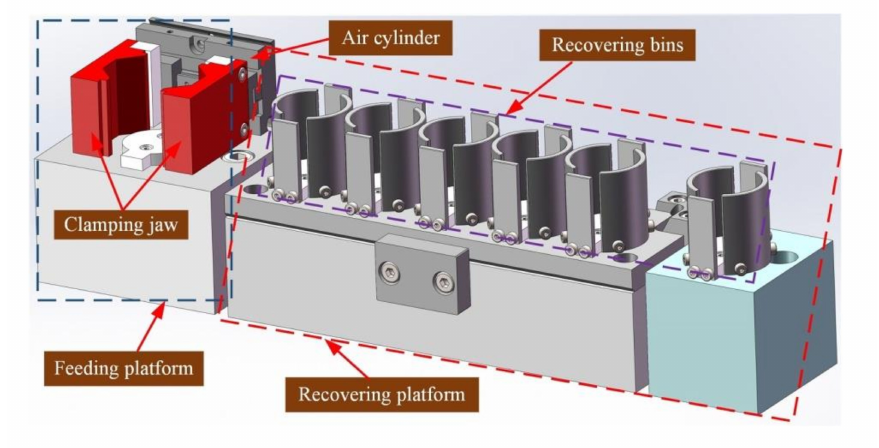
Figure 4. Structure of the loading / blanking module.